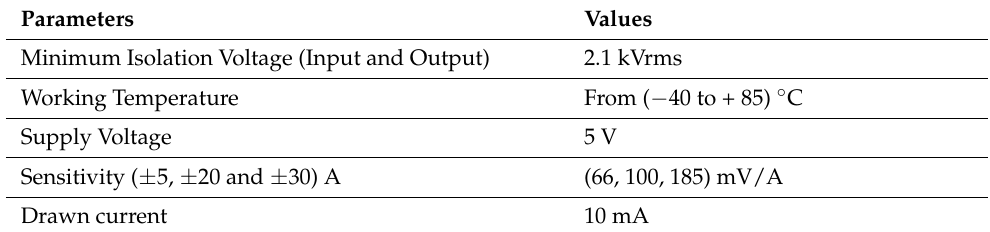
Table 5. Main features of the ACS712 sensor [46,47].